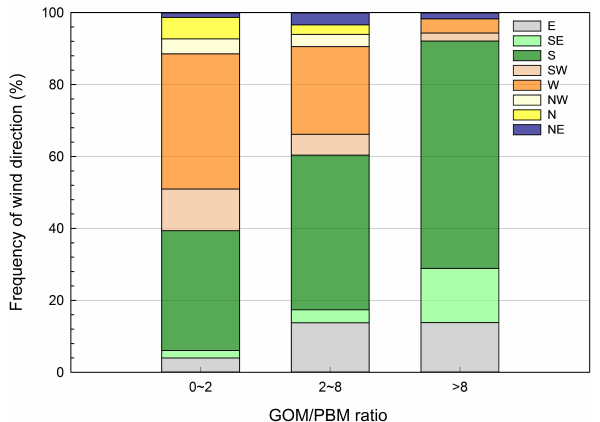
Figure 6. Frequency of wind direction with different GOM / PBM ratios. Southerly and easterly winds prevailed for the samples with high GOM / PBM ratio whereas the percentage of westerly winds increased as the GOM / PBM ratio